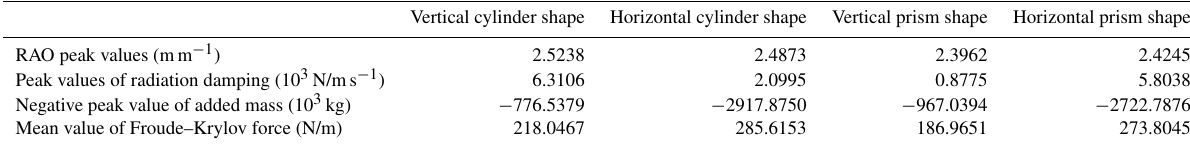
Table 3. Comparison of the energy efficiency between cylindrical and prismatic floating bodies with different postures. Vertical cylinder shape